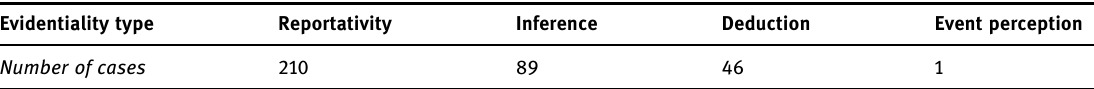
Table 3: Distribution of types of evidentiality in the sample Evidentiality type